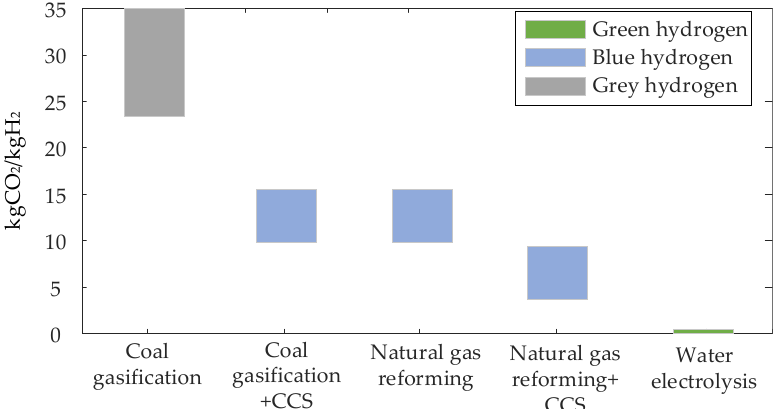
Figure 1. Comparison of the carbon emissions of different hydrogen production methods.